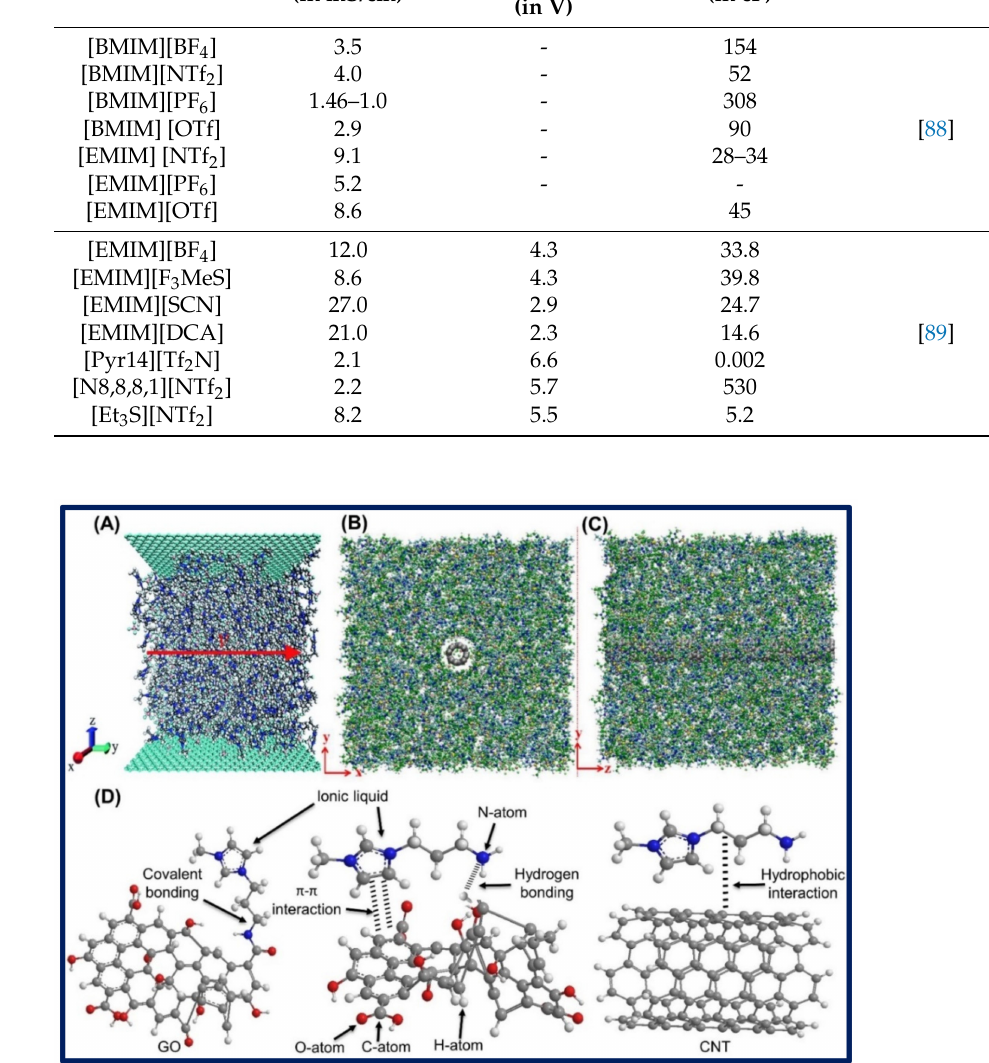
Figure 10. ( A ) The initial structure of the ensemble includes cubic bulk RTILs droplet and GR nanochannel. Reprinted with permission from Ref. [91]. Copyright 2018, Royal Society of Chemistry. ( B , C ) The typical equilibrium snapshots (including the top and side views) for the ILs mixture of equimolar (EMIM)(BF 4 ) and (BMIM)(PF 6 ) around the CNTs. Reprinted with permission from Ref. [92]. Copyright 2020, American Chemical Society. ( D ) Covalent and non-covalent interaction of ILs with